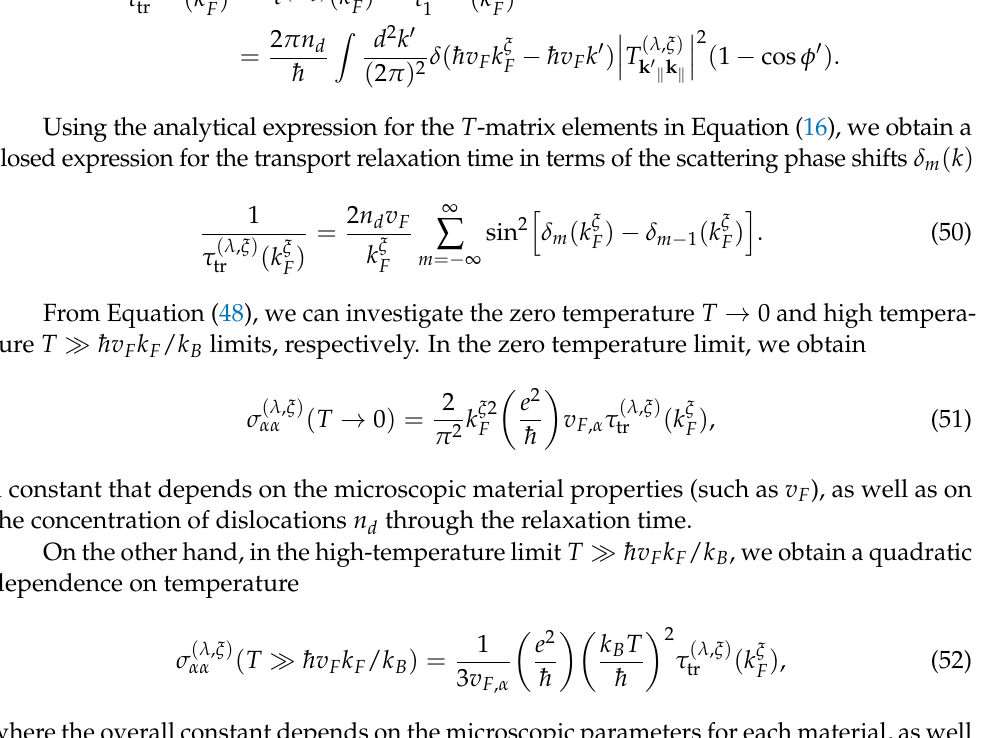
computed from the carrier densities reported in Ref. [26]. F